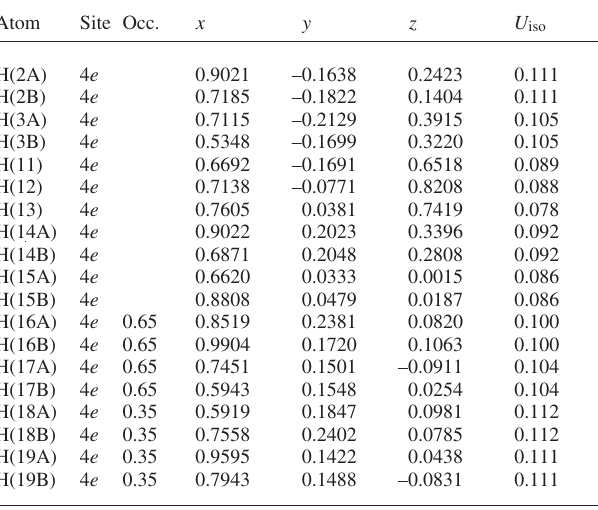
Table 2. Atomic coordinates and displacement parameters (in Å 2 )